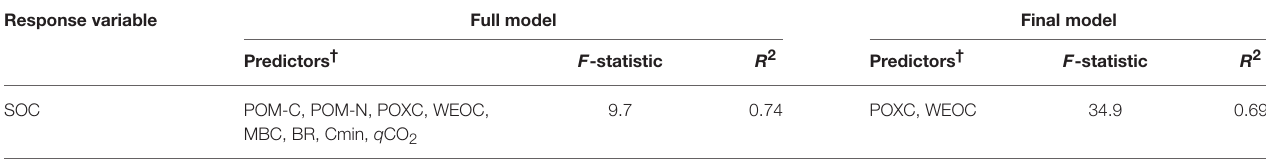
TABLE 6 | F -statistic and total variability ( R 2 ) of the best stepwise multiple linear regression model for predicting soil organic carbon